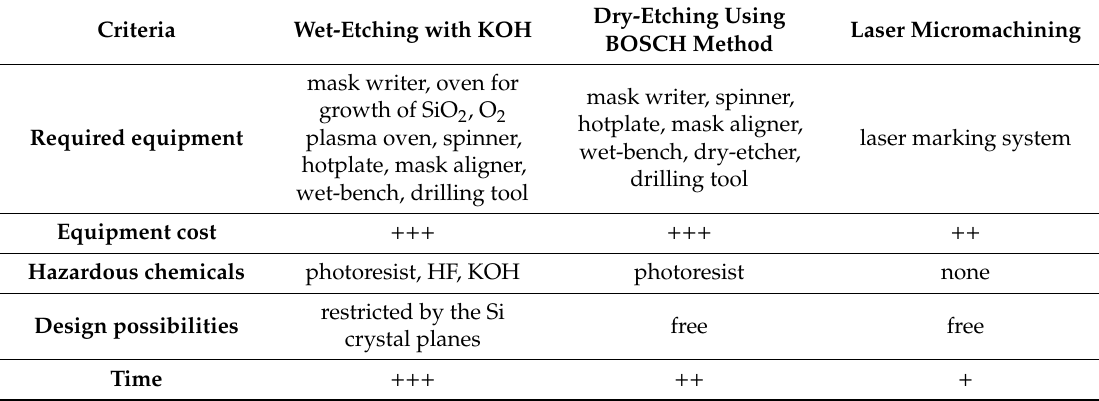
Table 1. Comparison between conventional silicon processing and laser